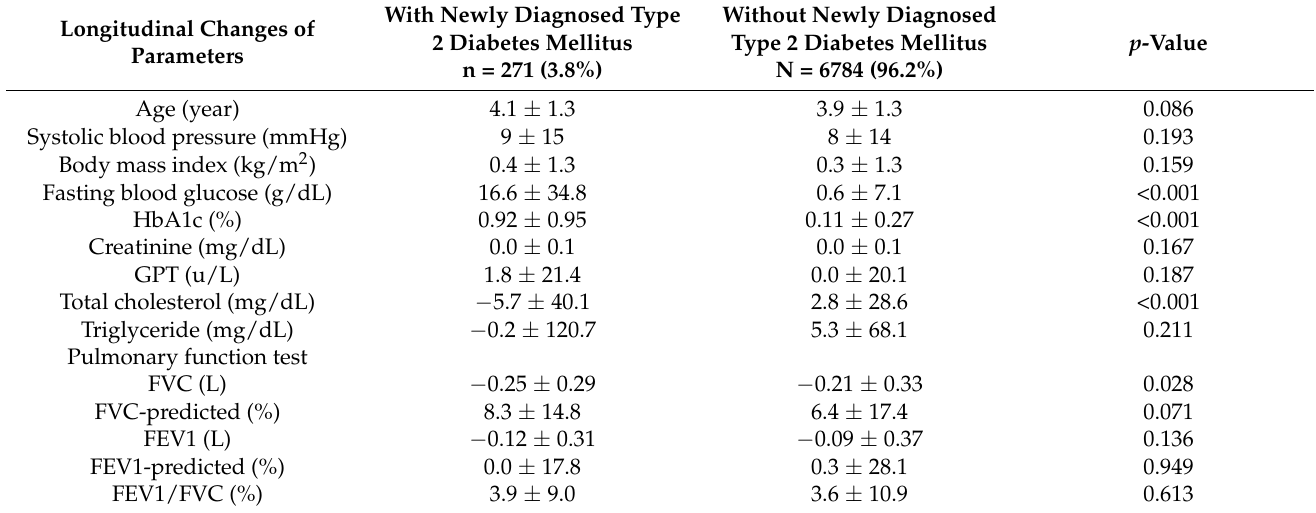
Table 5. Comparison of longitudinal changes of clinical, laboratory, and pulmonary function data between participants with and without newly diagnosed type 2 diabetes